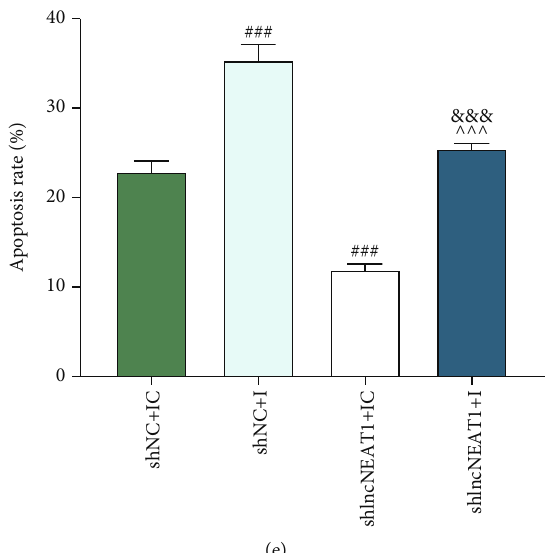
Figure 8: NEAT1 downregulation promoted the viability and suppressed the apoptosis of OGD-induced HCMs by upregulating miR-582- 5p expression. (a, b) After cells received transfection and OGD induction, the expressions of NEAT1 (a) and miR-582-5p (b) in HCMs were evaluated by qRT-PCR. (c) After cells received transfection and OGD induction, the viability of HCMs was detected by CCK-8 assay. (d, e) After cells received transfection and OGD induction, the apoptosis of HCMs was evaluated by fl ow cytometry. ( # P < 0 : 05 and ### P < 0.001, vs. shNC+IC; ^ P < 0 : 05 and ^^^ P < 0 : 001 , vs. shNC+I; & P < 0 : 05 and &&& P < 0 : 001 , vs. shlncNEAT1+IC) (HCMs: human cardiac myocytes; NEAT1: nuclear paraspeckle assembly transcript 1; OGD: oxygen-glucose